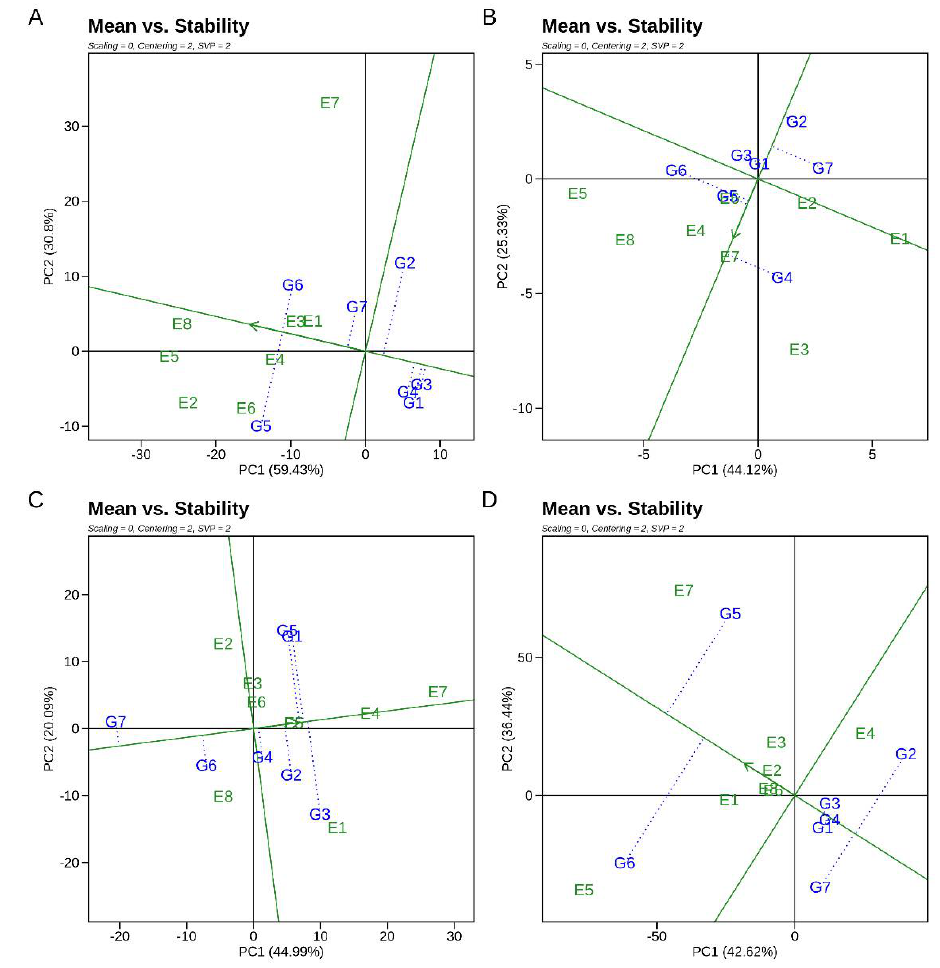
Figure 5. The GGE biplot ‘Mean versus stability’ pattern of genotype x environment interaction of 5 GSR lines and 2 control lines grown under eight environments in the year 2021 for ( A ) plant height, ( B ) the number of tillers, ( C ) grain yield, and ( D ) straw yield. The biplots were created with centering = 0, SVP = 2, and scaling = 0 parameters.